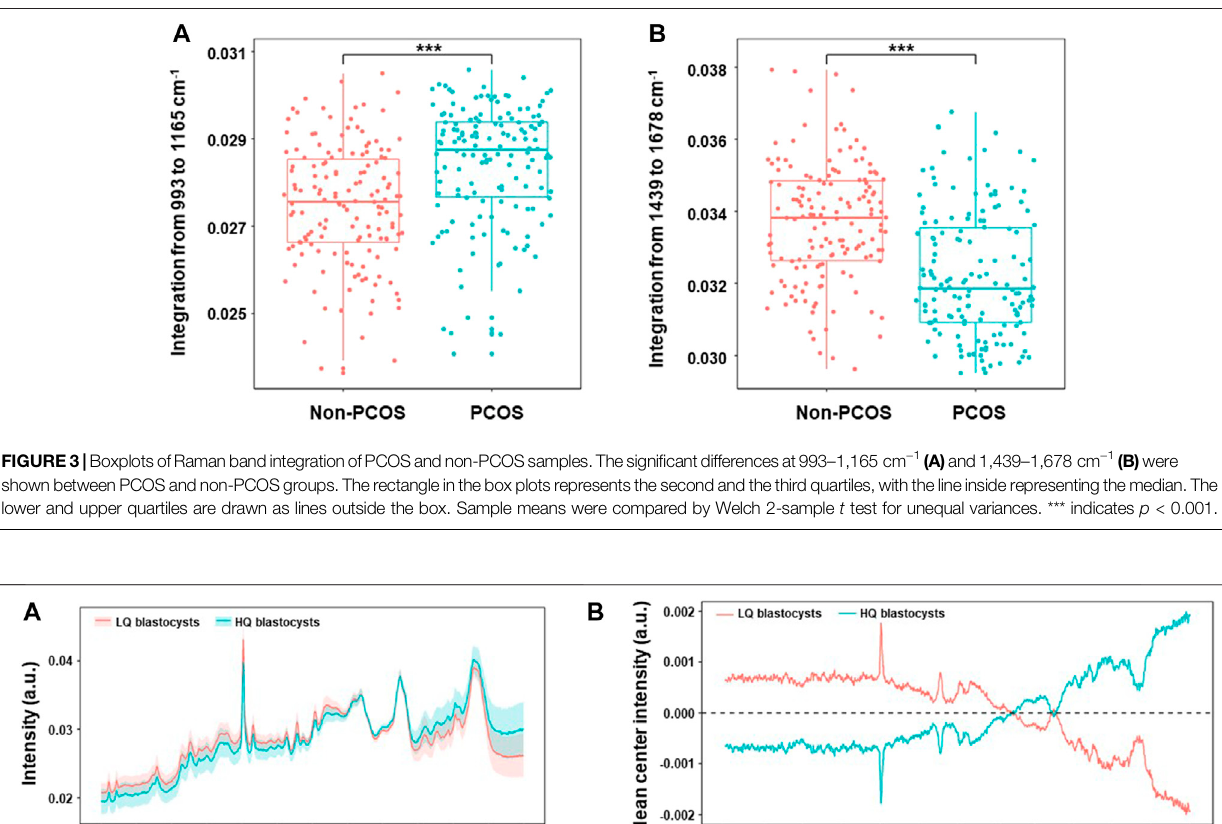
pregnancy success group ( n (cid:1) 85) and pregnancy failure group ( n (cid:1)